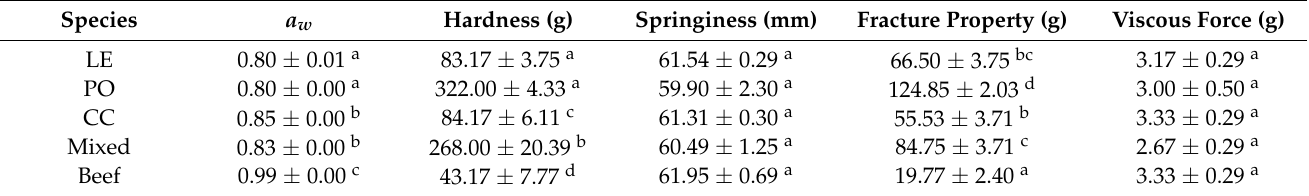
Table 2. The a w , hardness, springiness, fracture property and viscous force of MMSA with different species of edible mushroom and compared with beef.